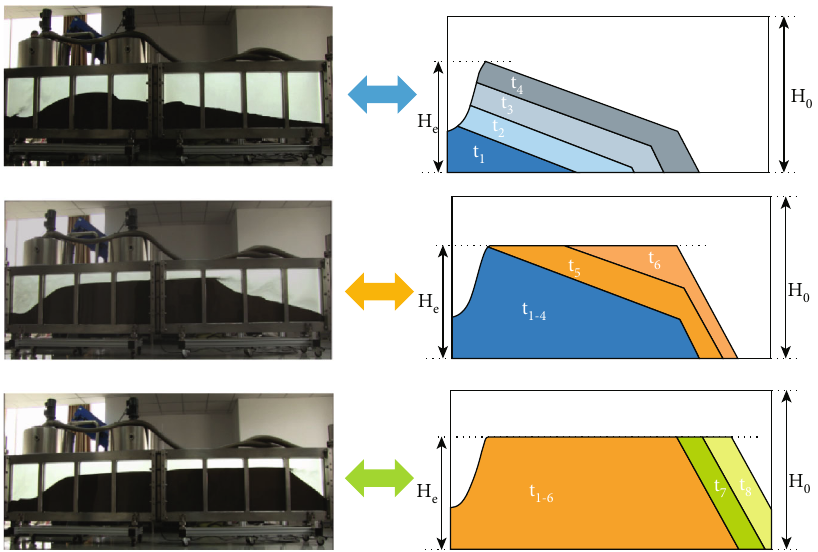
Figure 4: The process of sand carrying by slickwater and proppant transport.